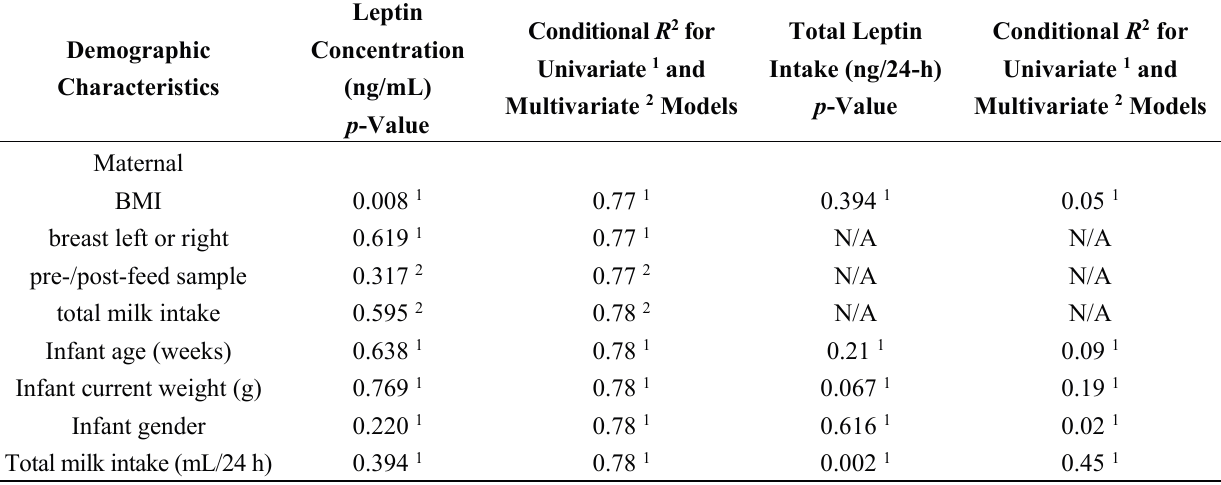
Table 4. Demographic characteristics of the breastfeeding dyads ( n = 19) and associations with skim milk leptin concentration (ng/mL) and total skim leptin intake (ng) over a 24-h period. Data is presented with p -values and conditional R 2 for univariate and multivariate